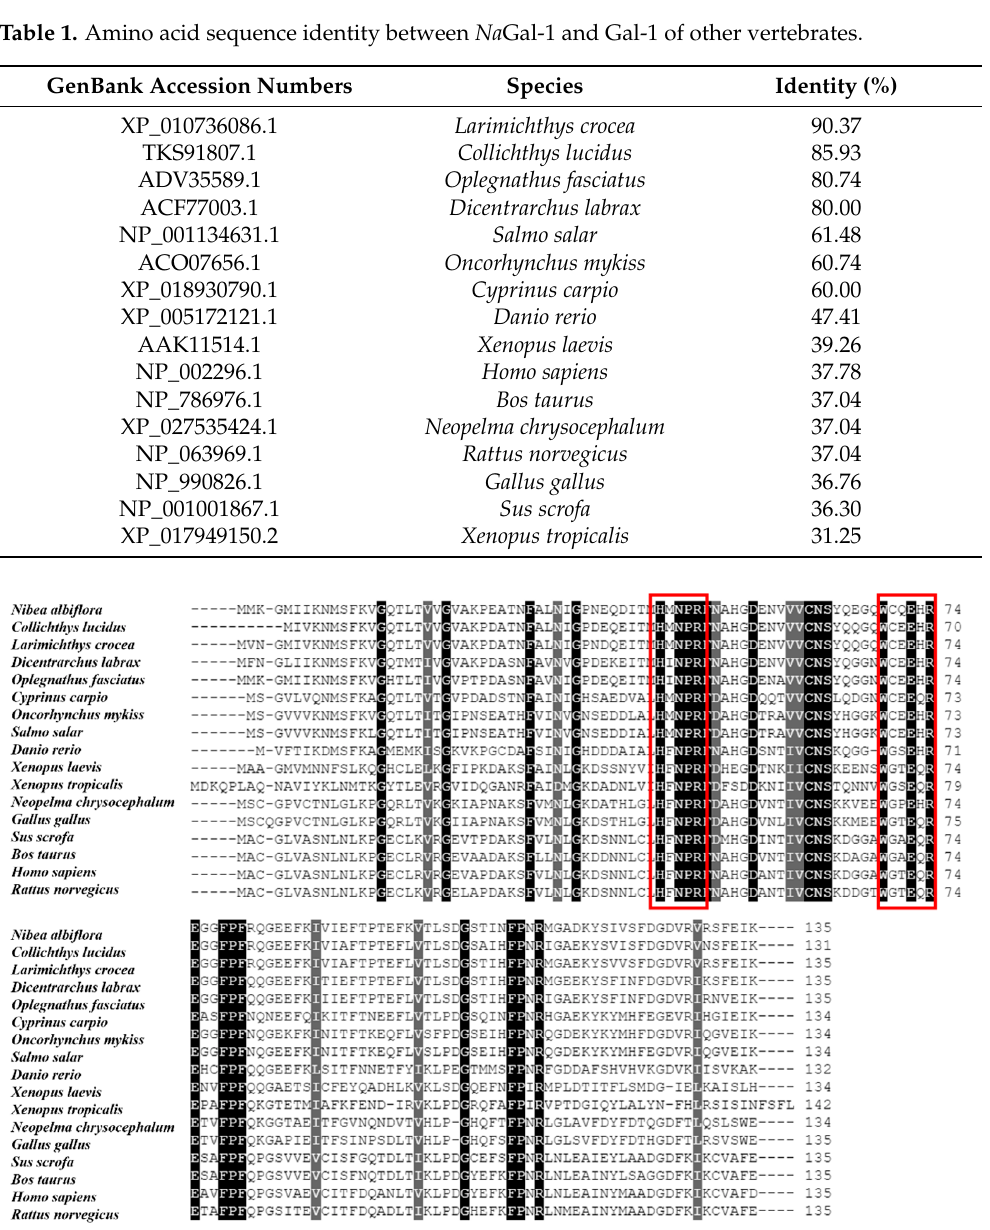
Figure 2. Multiple alignment of NaGal ‐ 1 amino acid sequences. The red boxes indicate the sugar binding motifs (H ‐ NPR and W ‐‐ E ‐ R), and the black shadows indicate identical amino acid.